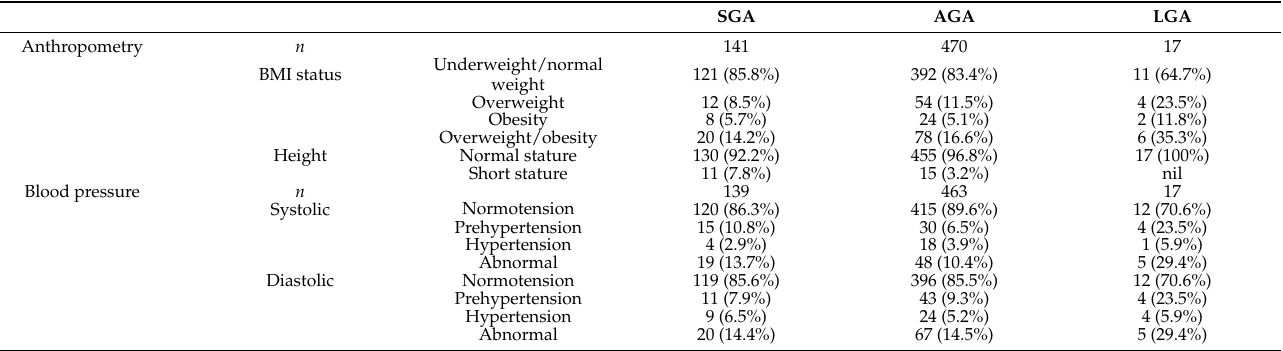
Table 3. Adverse anthropometric and blood pressure outcomes among young adults in Thailand according to their birth weight status.